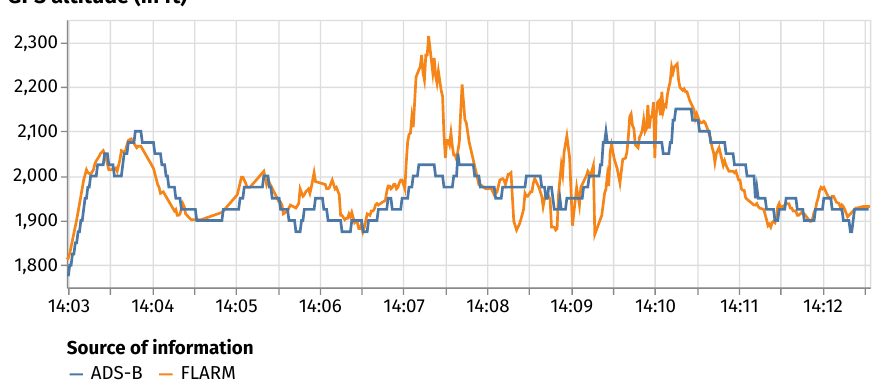
Figure 4. Aircraft F-JVZB (identifier 394f3c ) is equipped with both ADS-B and FLARM. Different GPS altitude data are however emitted: ADS-B broadcasts the aircraft current position, while FLARM estimates the position of the aircraft two seconds in the future for collision avoidance